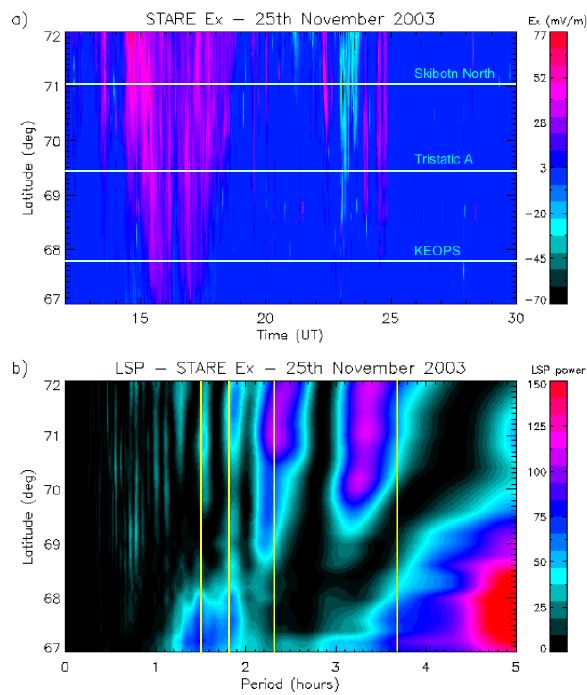
Fig. 16. STARE electric field (northwards component) for the 25 November 2003 (top) and LSP (bottom), at a longitude of 20.4 ◦ E. The latitudes of KEOPS, the tristatic A point, and the northernmost extent of the FPI data are marked with horizontal lines in the top plot. Vertical lines highlight some of the waves present in the